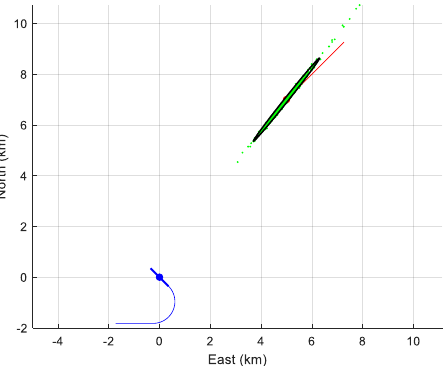
Figure 7. The cloud of the 500 initial positions estimates with the reduced state vector and the 90%−confidence ellipse.